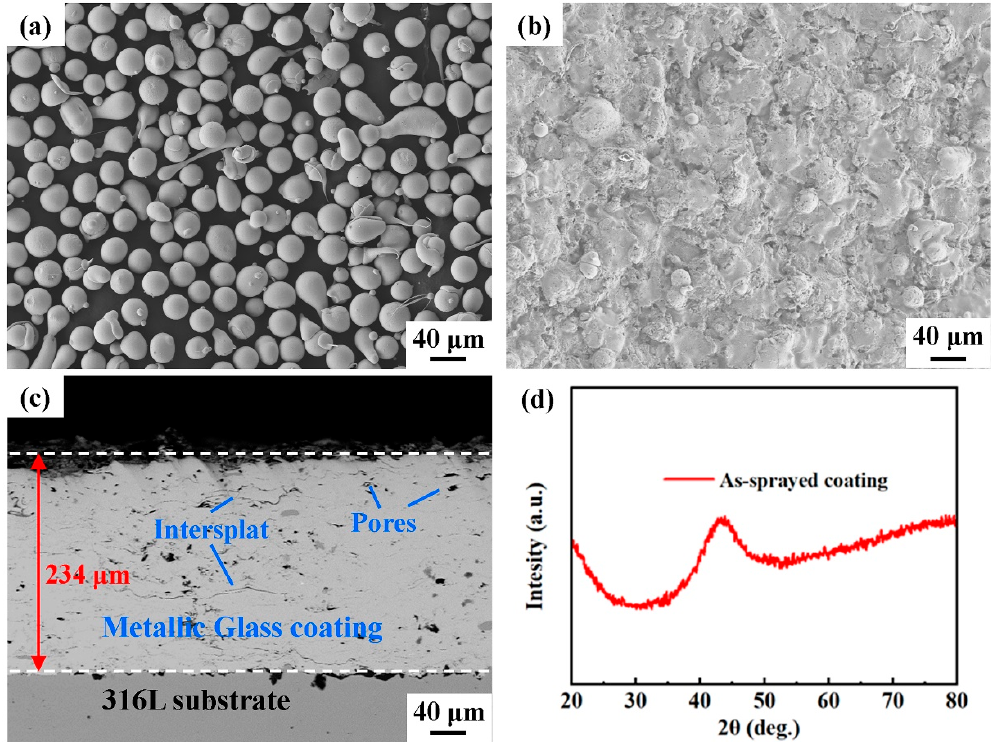
Figure 1. ( a ) Fe 43 Cr 20 Mo 10 W 4 C 15 B 6 Y 2 (at.%) feedstock powders. ( b ) Surface morphology of the as-sprayed coating. ( c ) Backscattered electron image of the cross-section of the as-sprayed coating. ( d ) XRD pattern of the as-sprayed coating. Table 1. Thermal spraying parameters for the HVAF